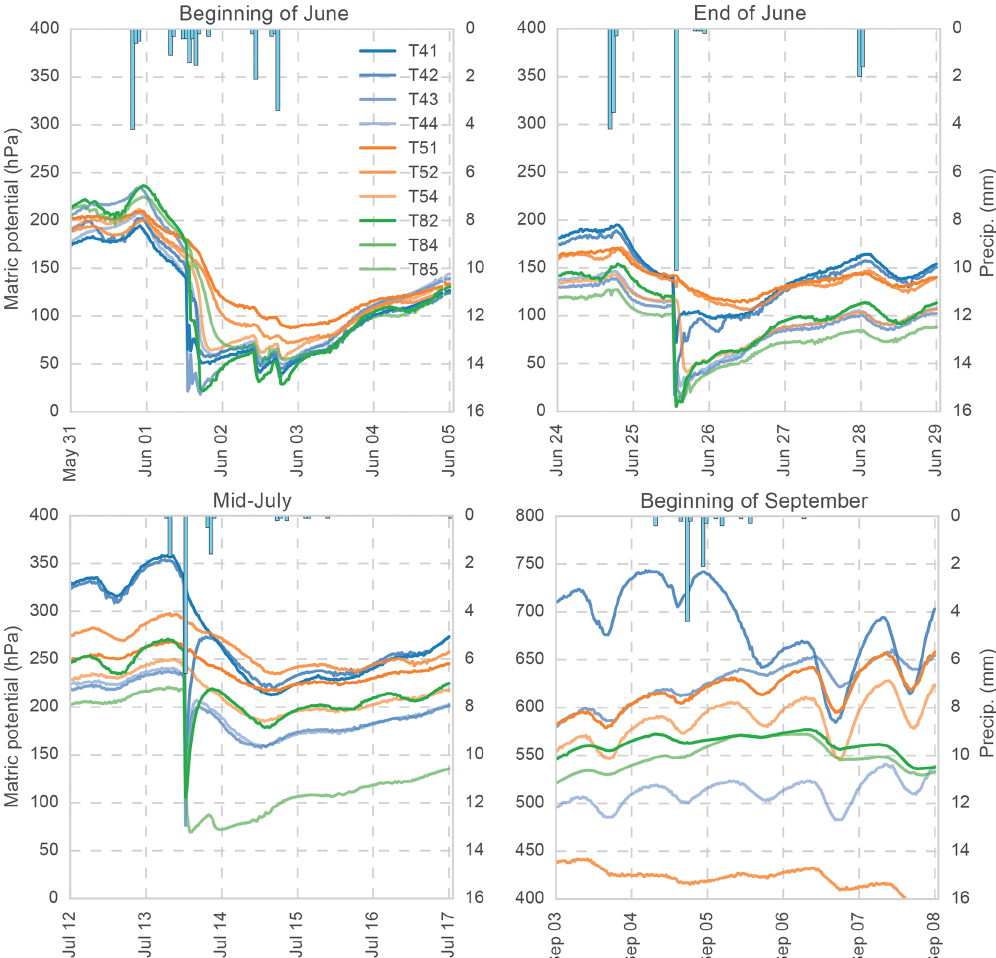
Figure 8. Reactions of all tensiometers (T4, T5, T8) to four events. Emerging redistribution structures at the surface lead to growing deviation of the soil states across relatively short